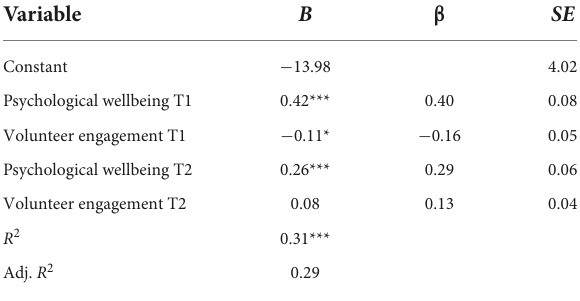
TABLE 6 Multiple linear regression coefficients of perceived organizational support on wellbeing and